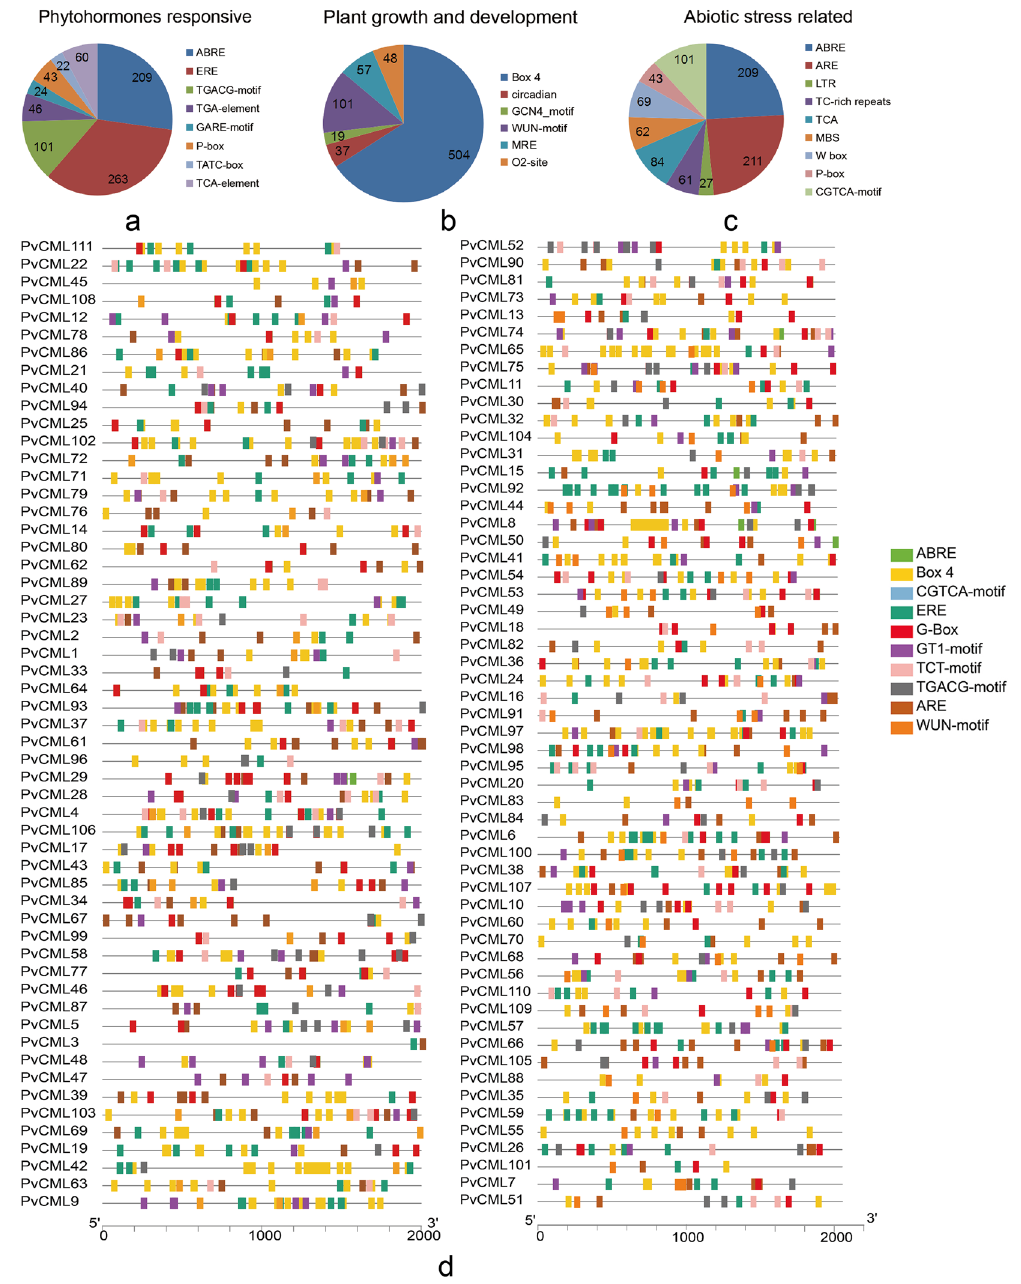
Figure 3. Cis -elements in the promoter regions of PvCMLs. ( a ) The number distribution of phytohormones responsive element, ( b ) plant growth and development related element, ( c ) abiotic stress response element and ( d ) distribution of top 10 cis -regulatory elements in each PvCMLs gene. Element is indicated by different colors in the